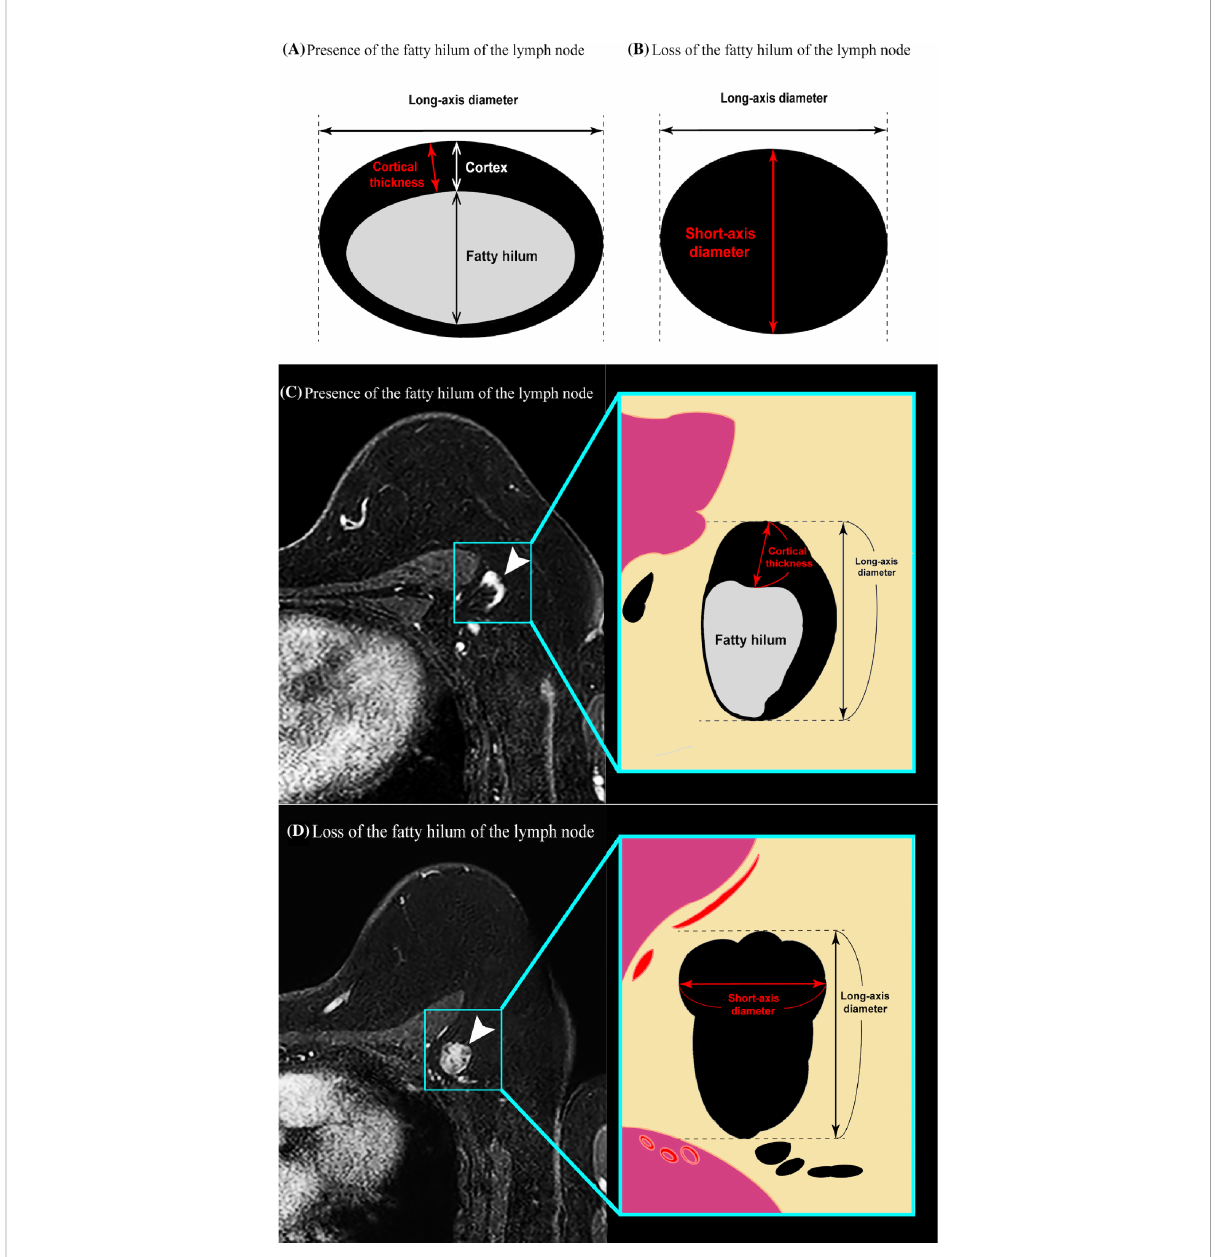
FIGURE 2 Diagrams illustrating the principle of the cortical thickness measurement method in a patient (A) in whom the hilum of the lymph node can be clearly identi fi ed versus a patient (B) in whom the hilum of the lymph node cannot be identi fi ed. In the former case, maximum cortical thickness was measured. In the latter case, the short-axis diameter was substituted for the cortical thickness. (C, D) Transverse contrast-enhanced T1-weighted MR images showing examples of the measurement of axillary lymph node cortical thickness in a patient (C) in whom the hilum of the lymph node can be clearly identi fi ed versus a patient (D) in whom the hilum of the lymph node cannot be clearly identi fi